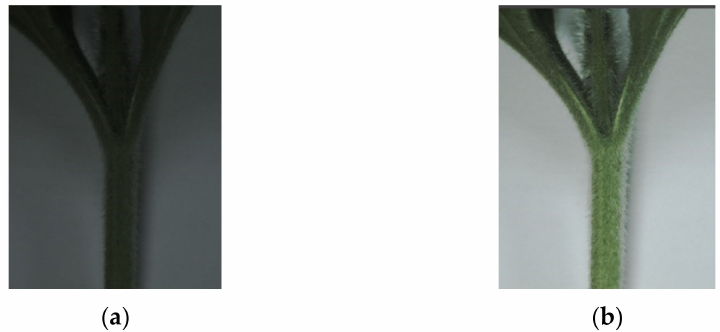
Figure 5. Grayscale change: ( a ) before grayscale change and, ( b ) after grayscale change.